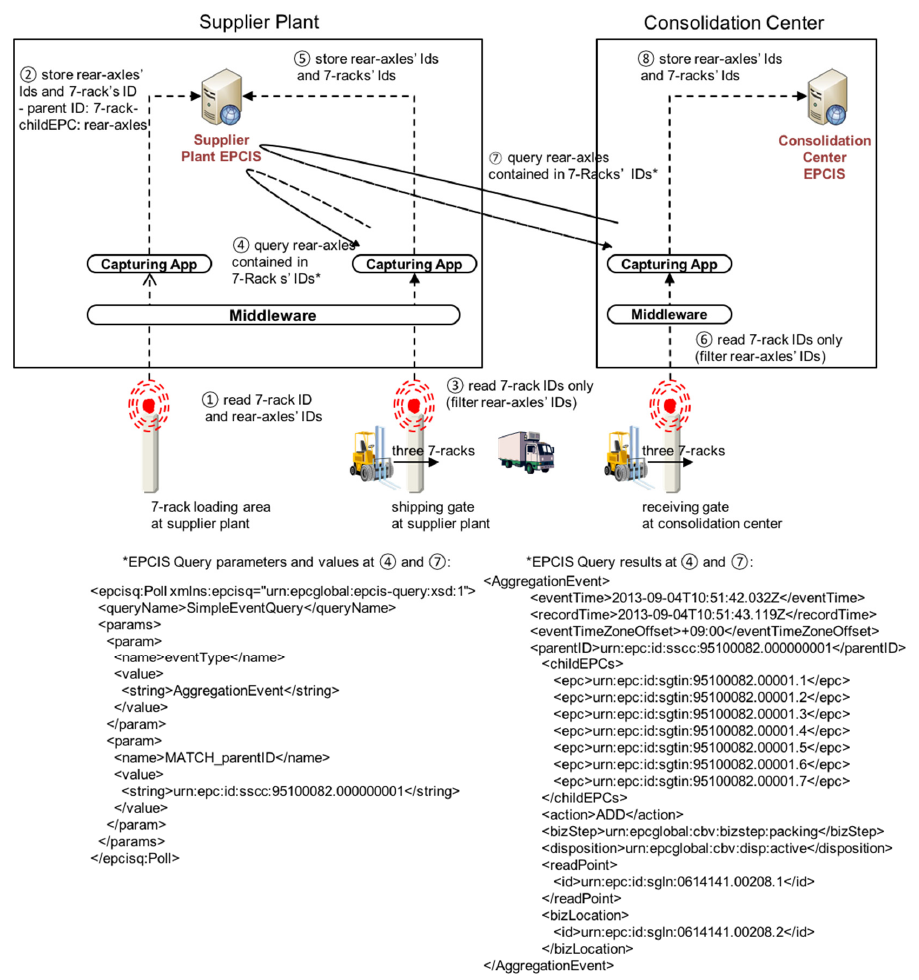
Figure 7. Electronic product code information services (EPCIS) query and query result at shipping and receiving processes.